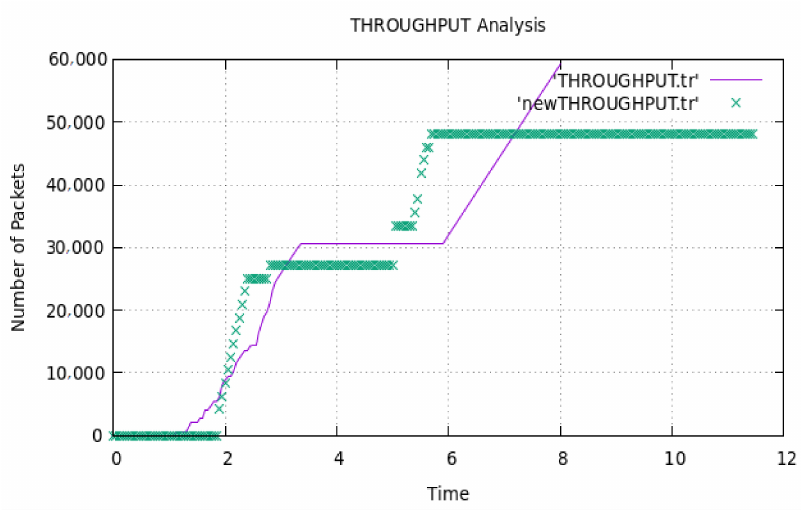
Figure 13. Throughput analysis of flying